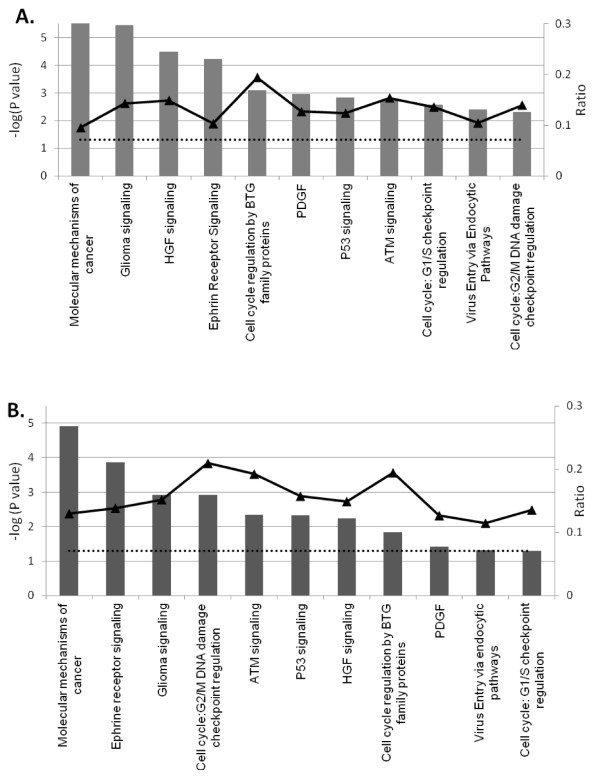
Major influenced canonical pathways of MPV-infected MK2 cells. Relevant pathways are shown at 3 (A) and 7 (B) hpi. The primary Y-axis shows the -log (P-value) of the probability for genes in data set to associate with identified pathway by chance. A threshold P-value of 0.05 or a -log (P) = 1.3 is presented in dotted line. The ratio of the number of genes from the data set that map to given pathway divided by the total number of genes that map to the canonical pathway is shown in solid line. All enlisted pathways met ratios ≥ 0.1 in at least one of the two time points (secondary Y-axis).